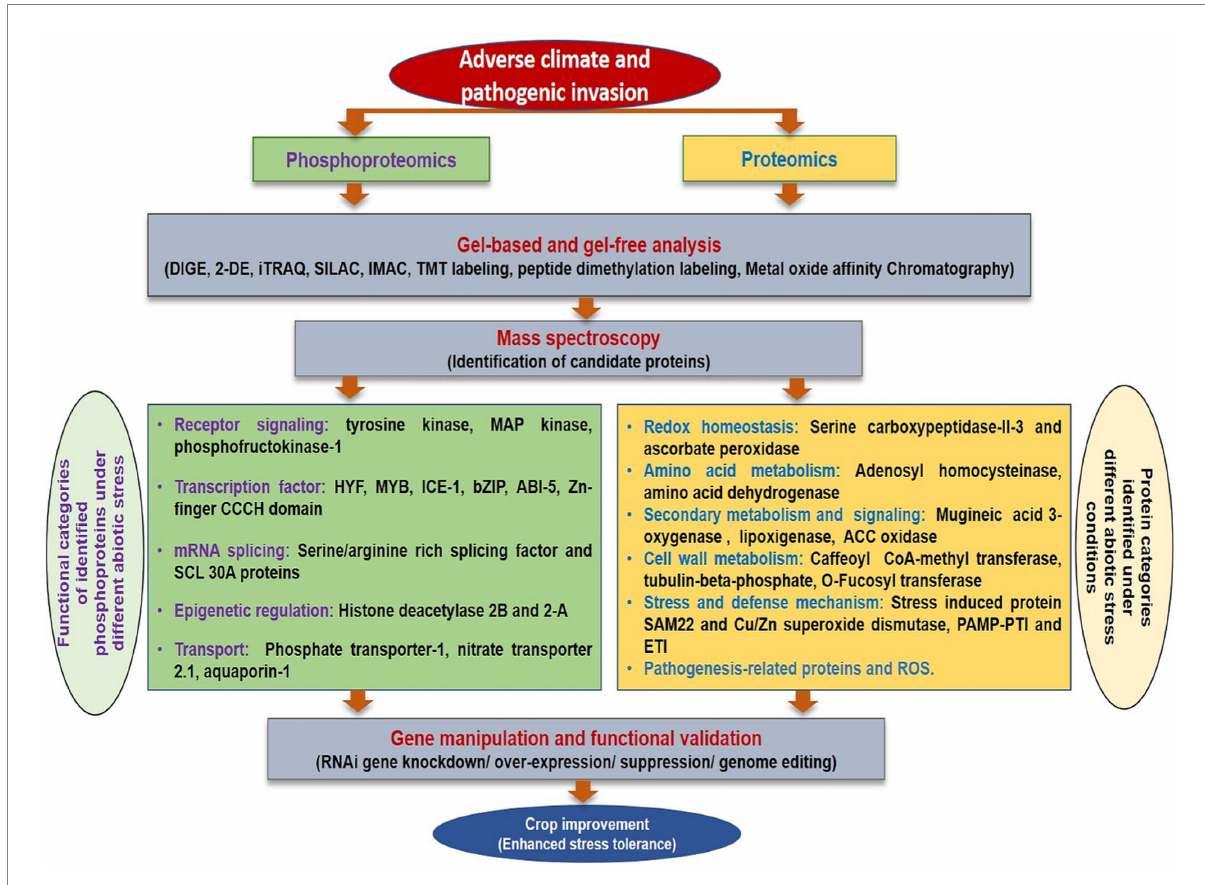
FIGURE 4 A comprehensive overview of proteomics and phosphoproteomics analysis under different